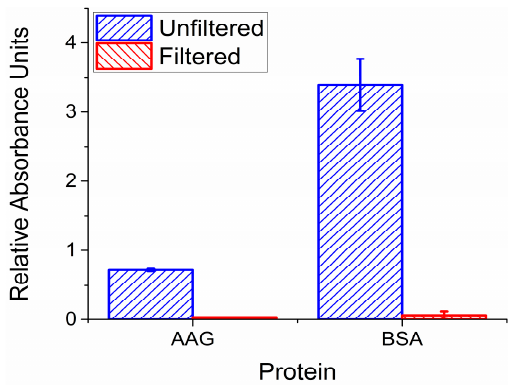
Figure 2. Relative absorbance of filtrate versus unfiltered solution containing protein in buffer. Low absorbance for the 100 µ L AAG and BSA solution filtrates indicate effective protein retention. Filtrate values displayed as mean ± standard deviation, n = 3.